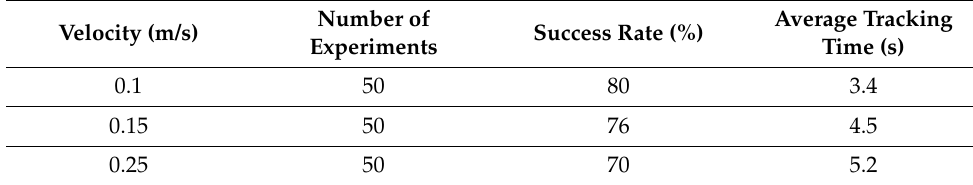
Table 5. Low resolution tracking and grasping results.